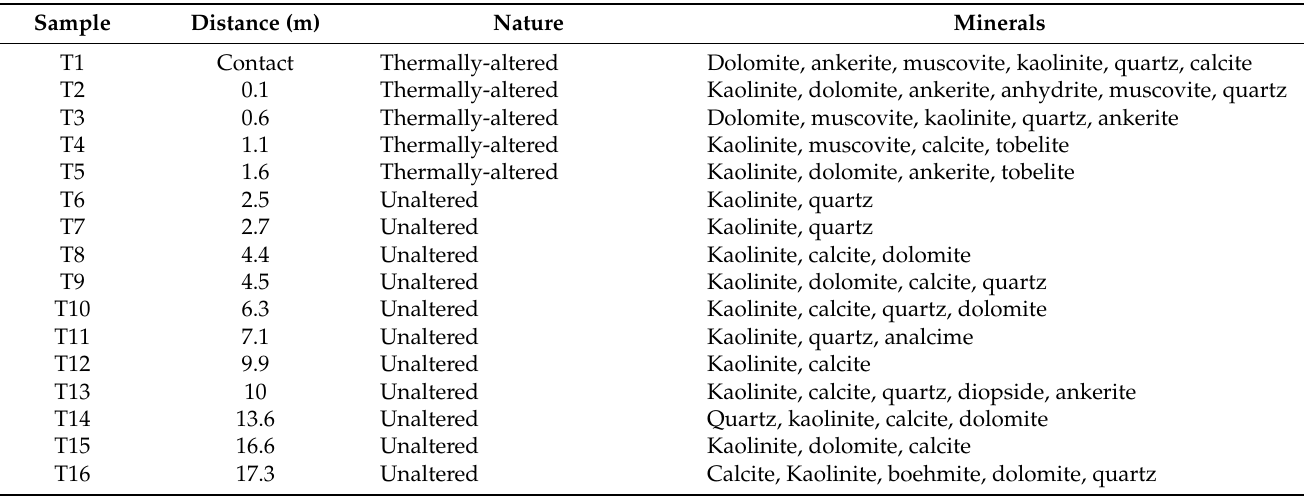
Table 5. Minerals identified in the Tashan